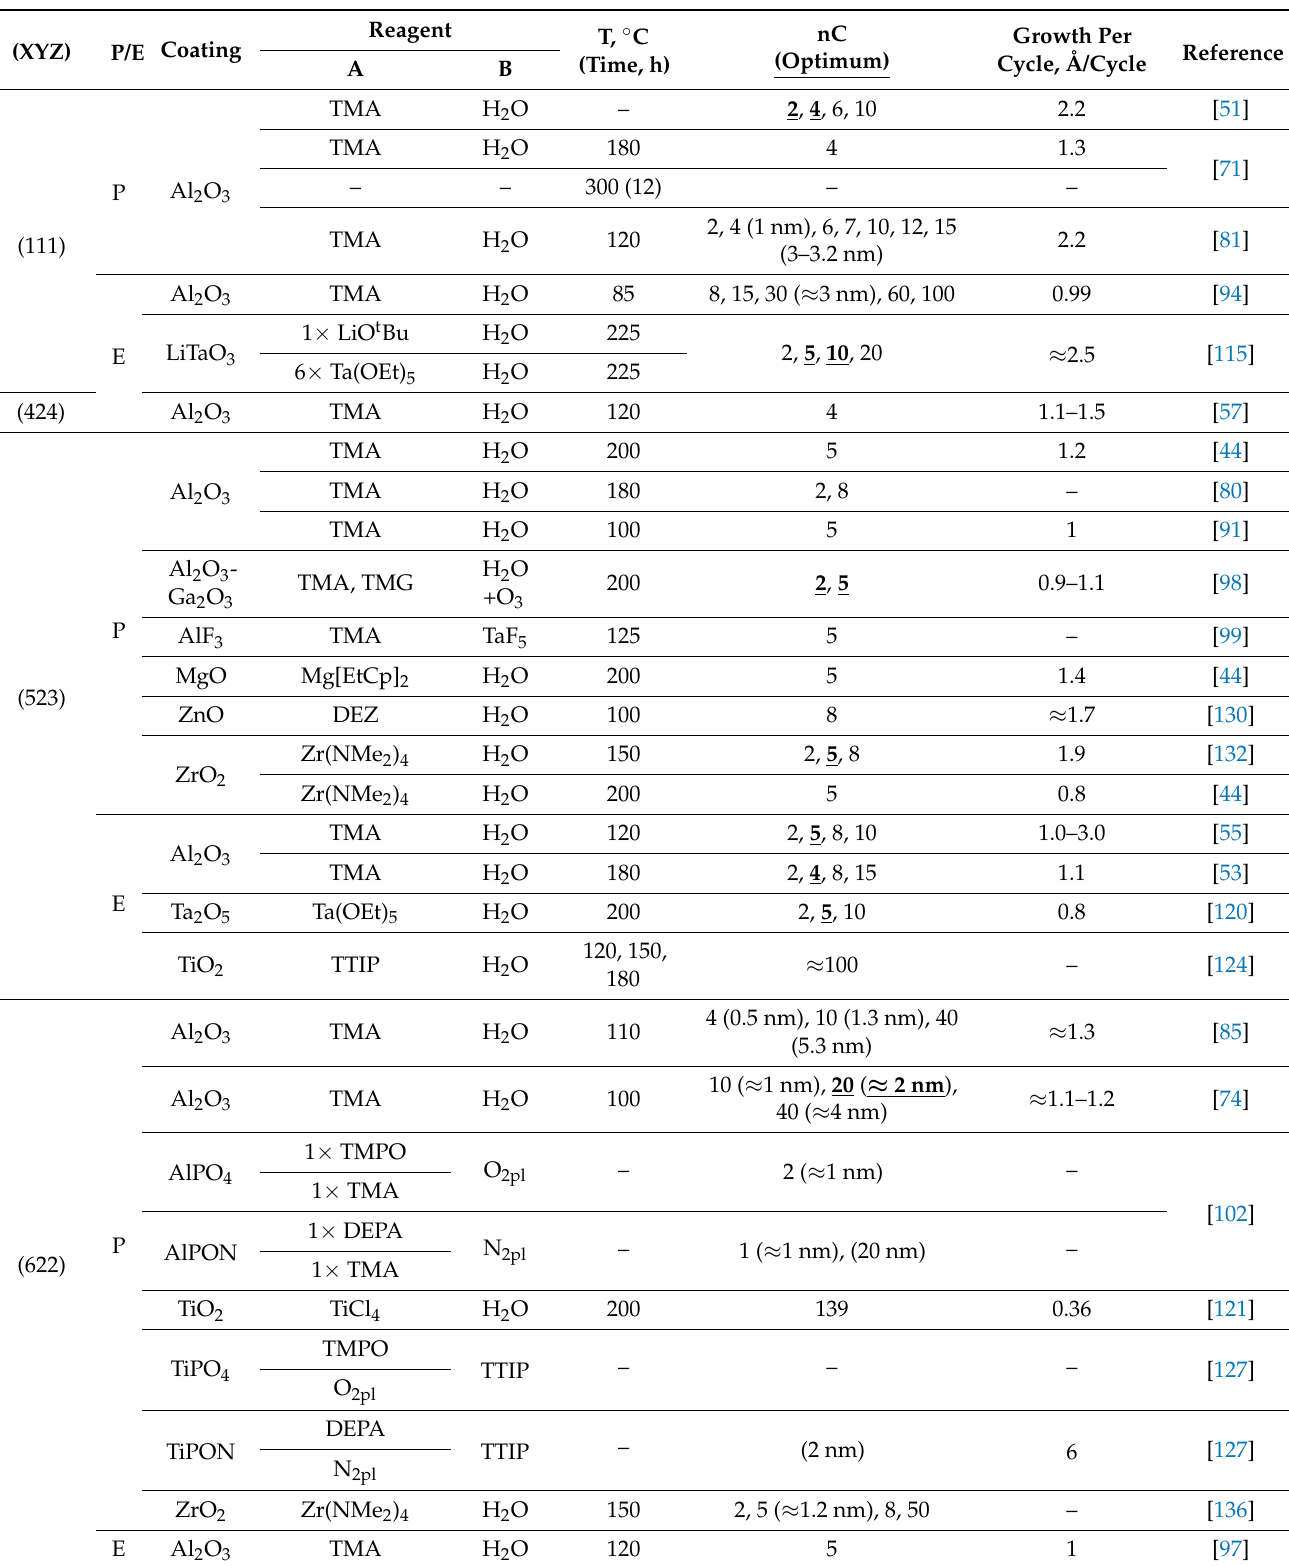
Table 3. Main parameters of NCM and NCA (LiNi 0.8 Co 0.15 Al 0.05 O 2 )